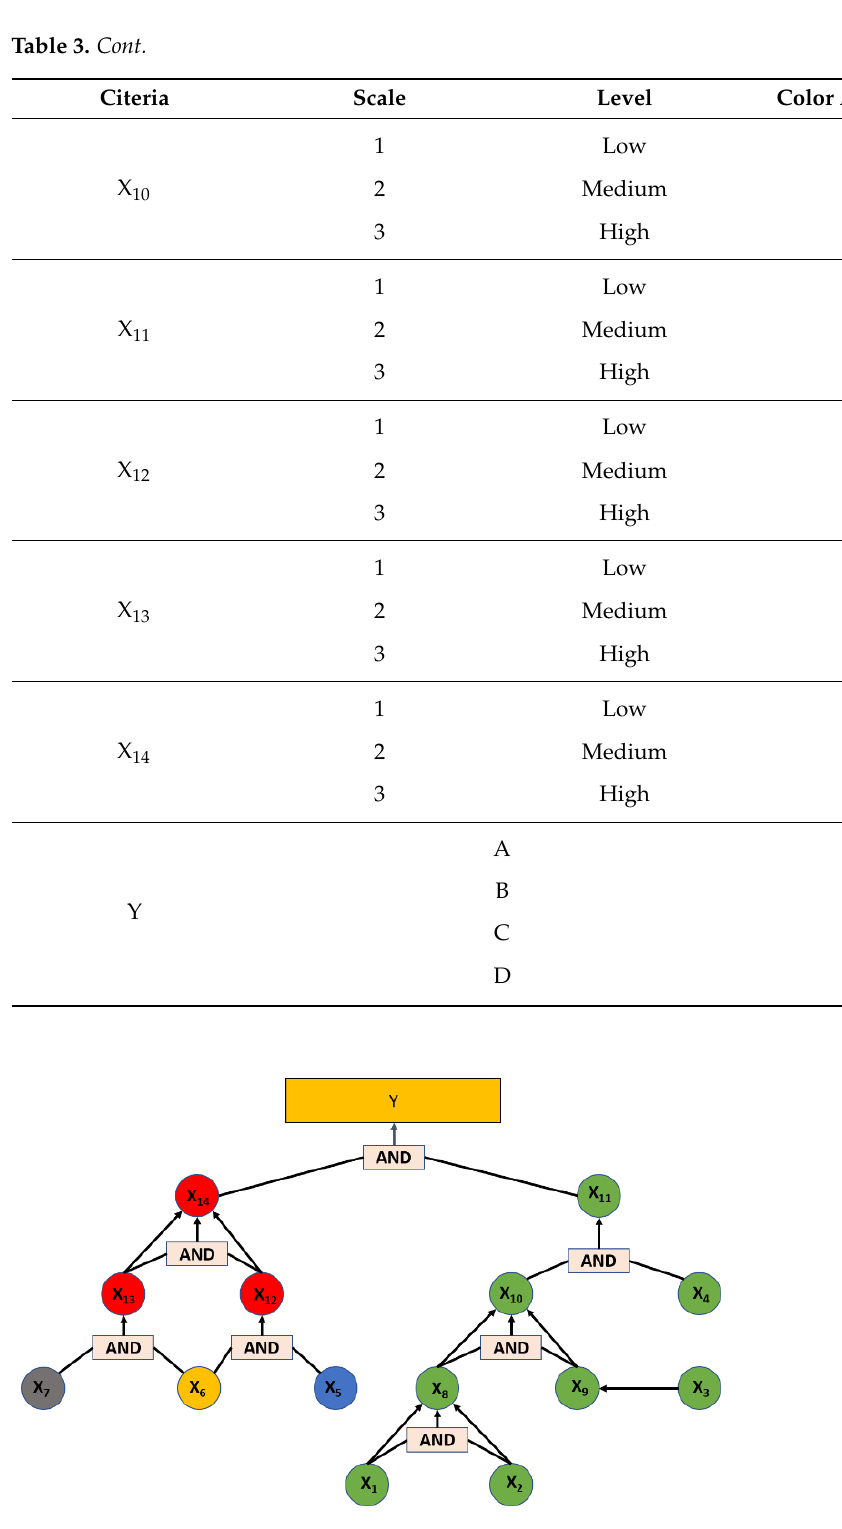
Figure 8. The hierarchical structure of spare part No. 144.